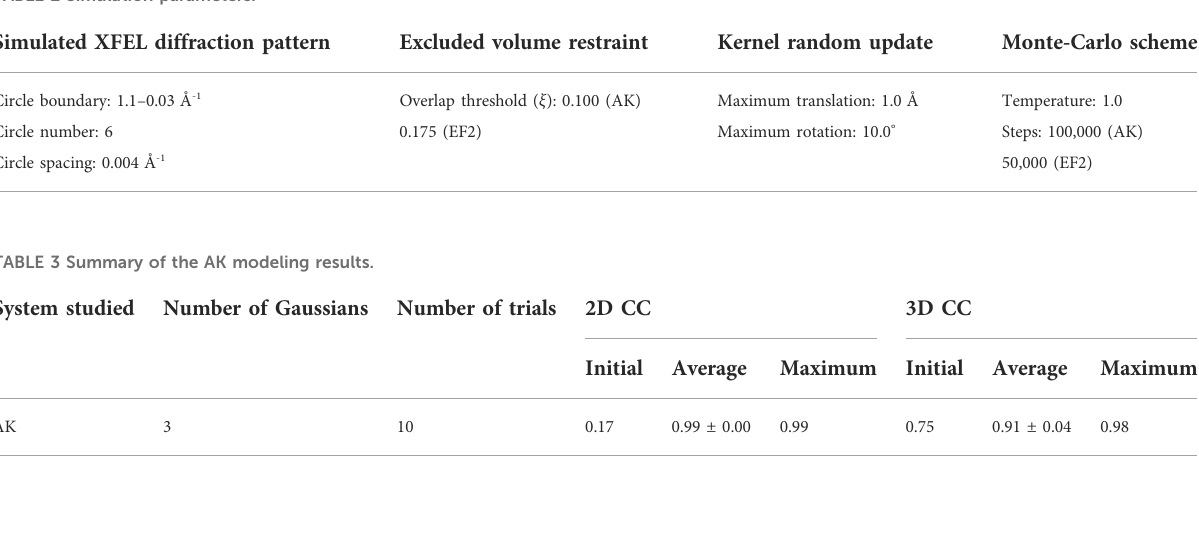
TABLE 2 Simulation parameters.